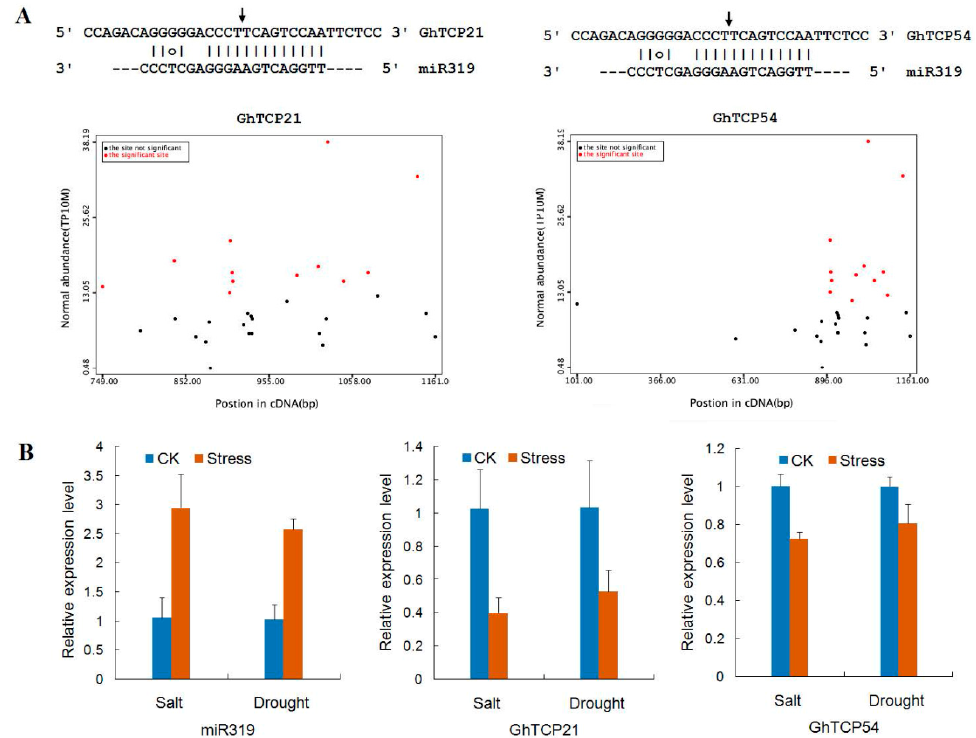
Figure 7. miR319 and its target genes, GhTCP21 and GhTCP54, in G. hirsutum . ( A ) Target plot (t-plot) for GhTCP21 and GhTCP54 , which were targeted by miR319. Arrows indicate the signatures corresponding to the miRNA cleavage site. Partial mRNA sequences of target genes aligned with the miRNAs show perfect matches (straight lines) and G-U wobbles (circles). ( B ) Relative expression levels of miR319, GhTCP21 , and GhTCP54 under salt and drought stresses. QRT-PCR analyses were performed using RNA generated from cotton leaves after NaCl and Polyethylene Glycol (PEG) treatment. Error bars represent standard error of the